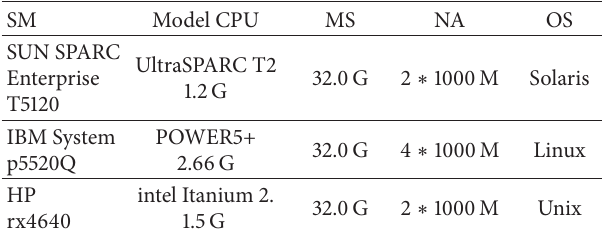
Table 1: Parameters of selected